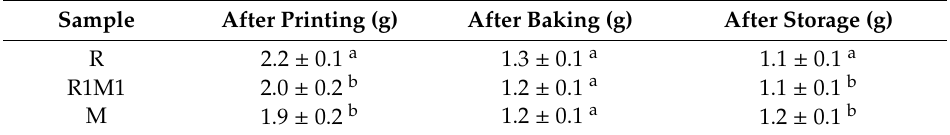
Figure 3. Appearance of 1-layer samples after ( a ) printing and (b ) baking. The cutting position in the hardness measurement is marked in the baked samples with a vertical dotted line. The cross-sectional images ( c ) were taken from the cut surface (scale bar 1 mm). Table 2. Weight of single-layer samples right after printing, baking and storage ( n ≥ 17).